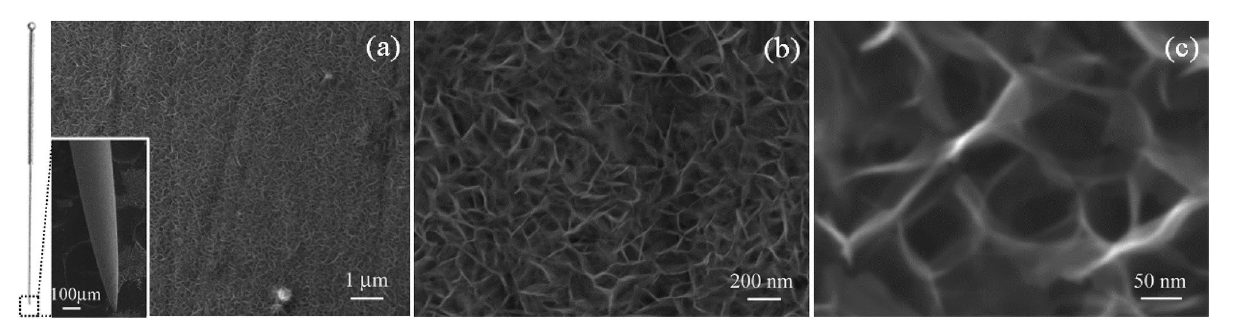
Figure 7. ( a ) Low-magnification SEM image of Ni 6 MnO 8 nanoflakes; inset: SEM image of the modified acupuncture needle. ( b , c ) High-magnification SEM images of the Ni 6 MnO 8 nanoflakes. Reproduced from Ref. [45] with permission from the Royal Society of Chemistry.